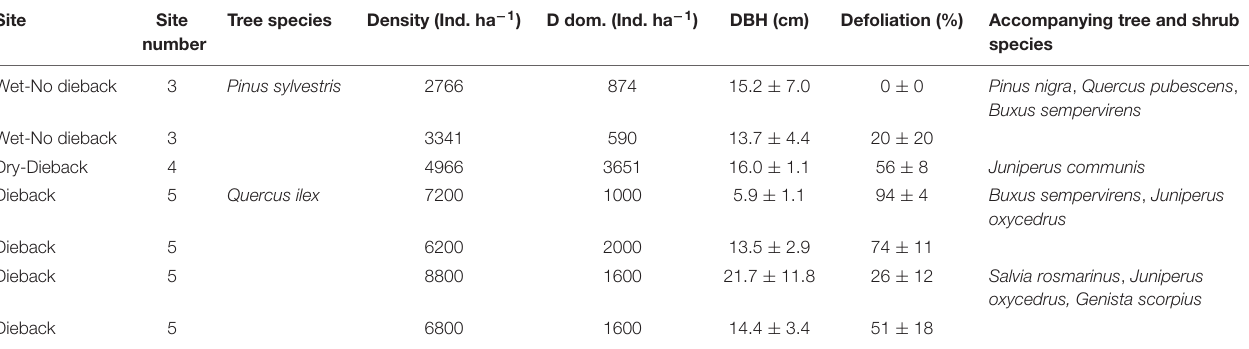
TABLE 2 | Quantification of drought-induced damage in climatically contrasting sites (wet P. sylvestris sites without dieback, a dry P. sylvestris site showing dieback, and four dry Q. ilex sites showing